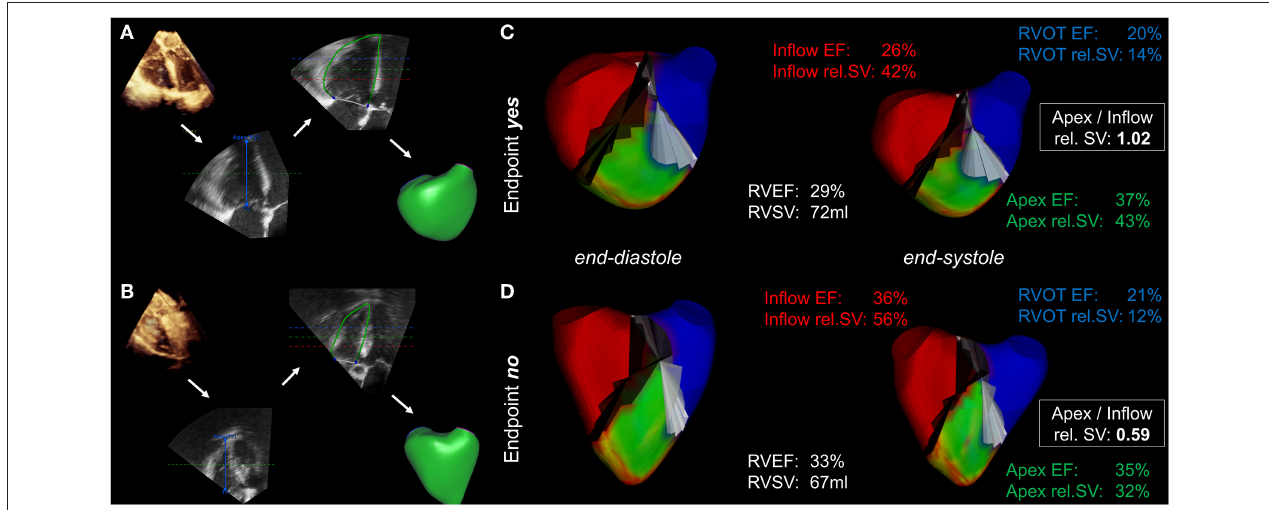
FIGURE 2 | Mesh-derived regional RV volumetry. Visualization of regional RV volumetry in a patient who reached the endpoint (A,C) compared with that in a patient with an uneventful postoperative course (B,D) . (A,B) The intraoperative 3D datasets undergo segmentation and endocardial borders are tracked using speckle-tracking technology, resulting in the generation of mesh models (workflow indicated by the white arrows). (C,D) Mesh-derived regional volumetry of the inflow (red), apex (green) and RVOT (blue). The displayed results include regional ejection fractions (EF), relative stroke volumes (rel. SV) and the apex to inflow rel. SV ratio. The cutting planes between the regions are colored black and white.